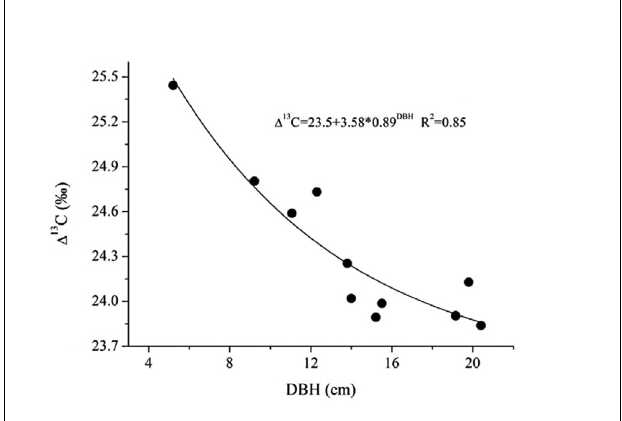
FIGURE 8 | Relationship between DBH and the leaf carbon isotope discrimination ( 13 C) of 11 trees for E. urophylla .